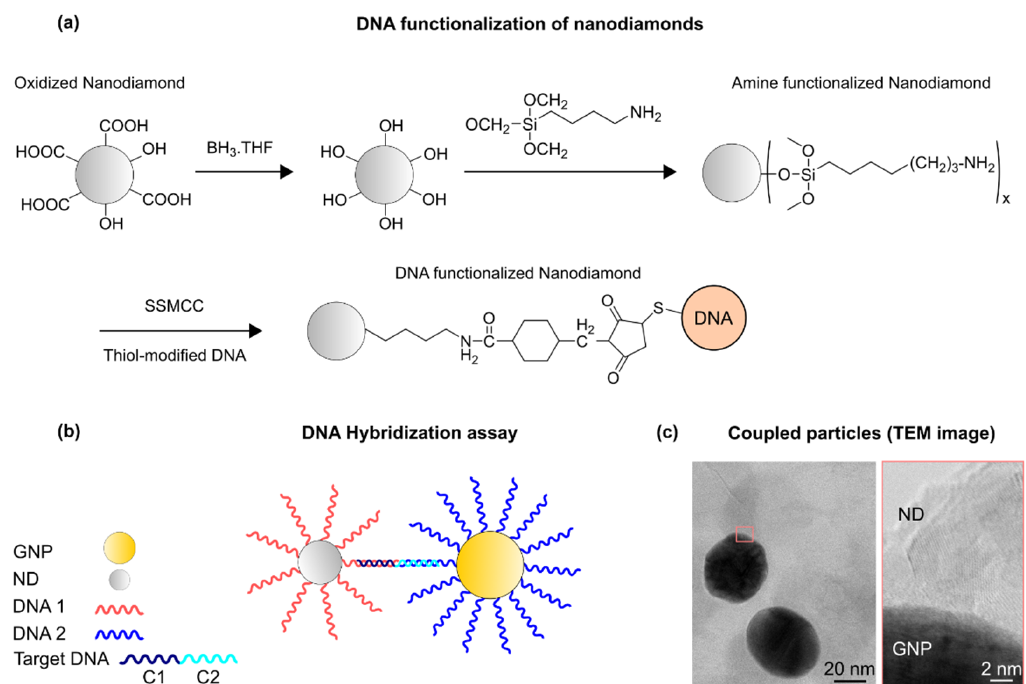
Figure 1. ( a ) DNA functionalization of nanodiamonds. ( b ) Principles of DNA-induced nanoassembly. DNA-functionalized nanoparticles form conjugates via hybridization by a target DNA that contains sequences complementary to both GNP and nanodiamond tags. Nanodiamonds and GNPs are functionalized with DNA1 and DNA2, respectively. The target DNA is composed of C1 and C2, complementary sequences to DNA1 and DNA2, respectively. ( c ) A transmission electron microscope (TEM) image of a coupled GNP–nanodiamond structure.